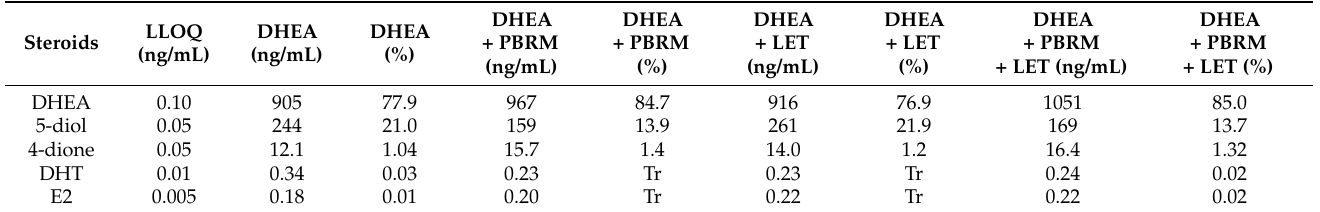
Table 1. Effect of enzyme inhibitors on DHEA metabolism in T-47D breast cancer cells 1 .